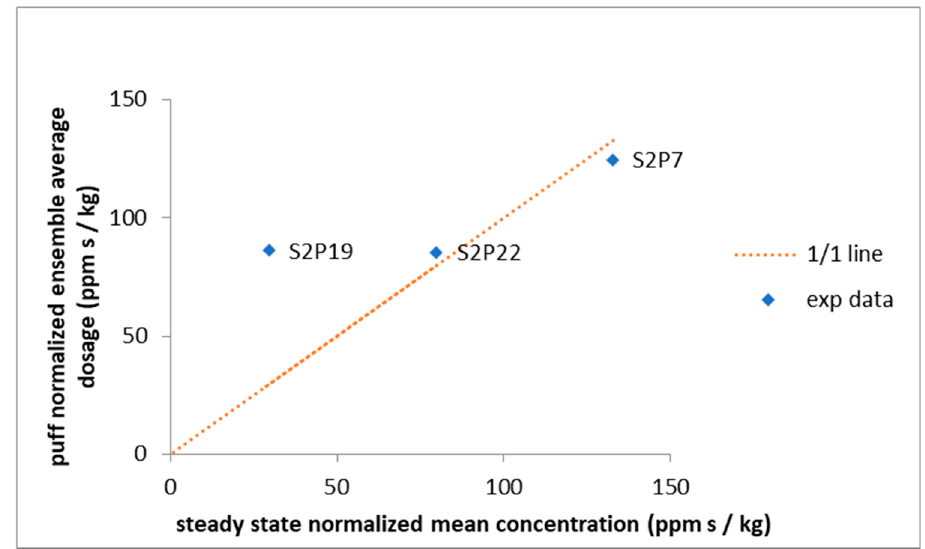
Figure 3. Puff release normalised ensemble average dosage vs. continuous release normalised mean steady state concentration: ensemble averages and means as expressed in Equation (12).